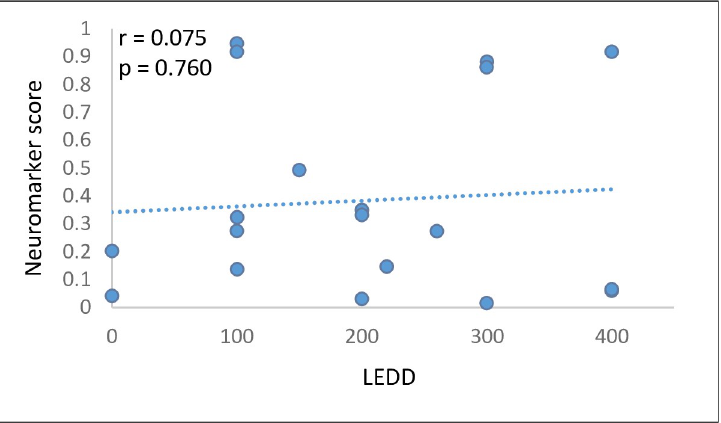
Fig 4. BNA Neuromarker scores as a function of LEDD. LEDD, levodopa equivalent daily dose.